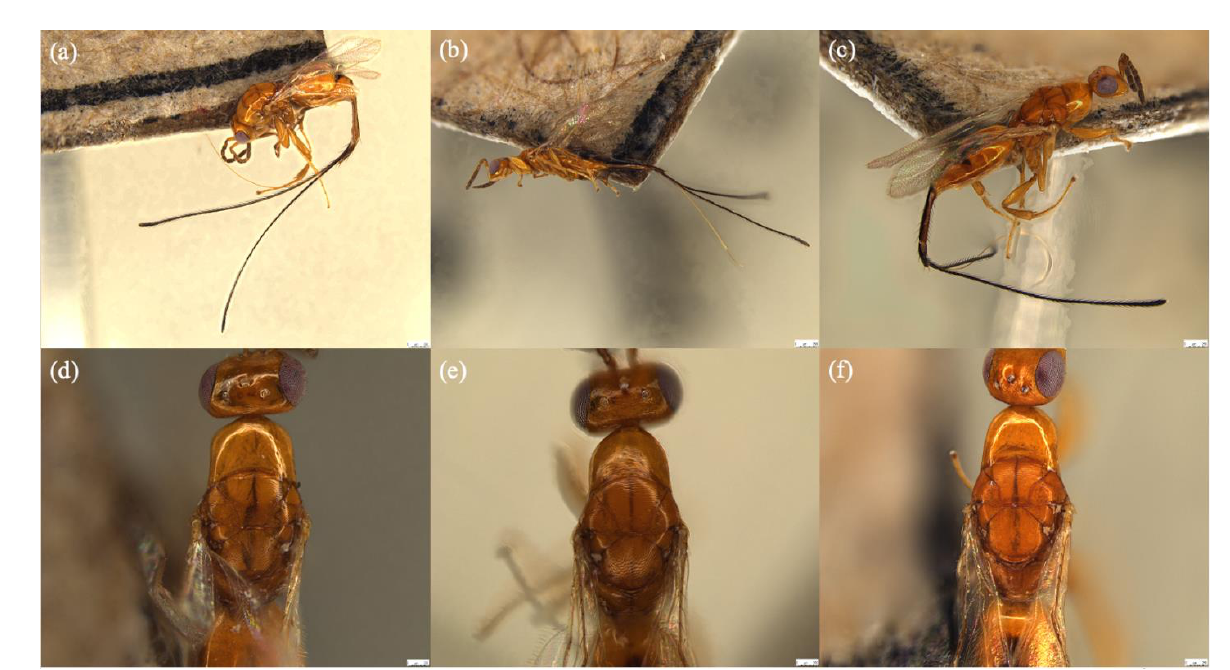
Figure 1. Habitus lateral of ( a ) Philotrypesis guangdongensis sp. n.; ( b ) P. yunnanensis sp. n.; ( c ) P. fu- jianensis sp. n. Mesosoma, dorsal view of ( d ) P. guangdongensis ; ( e ) P. yunnanensis ; ( f ) P. fujianensis . Noted that the black band of P. yunnanensis on scutellum is indistinct. Scale bars represent 250 μm.